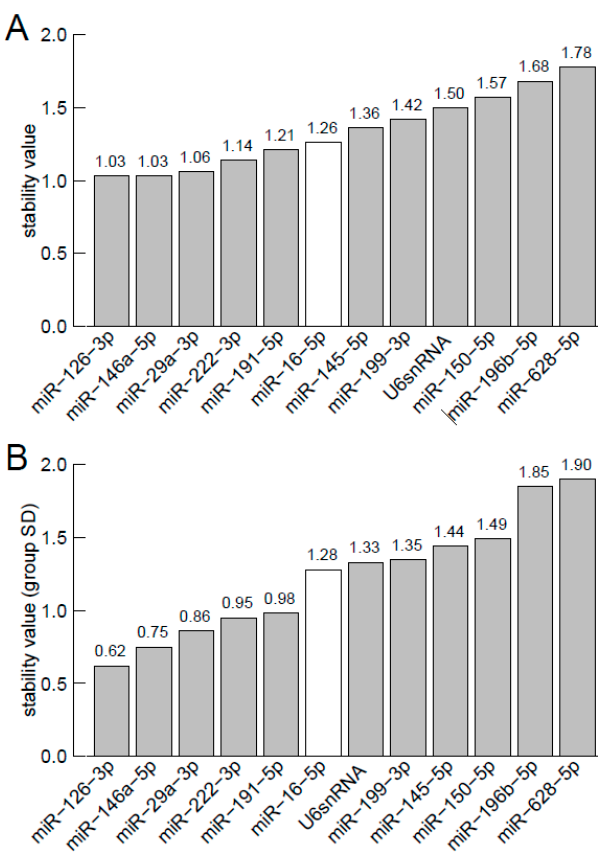
a rho ≥ 0.8 are greyed out, M: average expression stability value, PRIM: primary tumor, METAS: Metastasis, ALL: all 58 patients; * microRNAseq data of the The Cancer Genome Atlas (TCGA) breast adenocarcinoma (BRCA) analysis (including 755 patients); ** Stability values from NormFinder analysis are given based on the estimated intragroup variance for the given group.